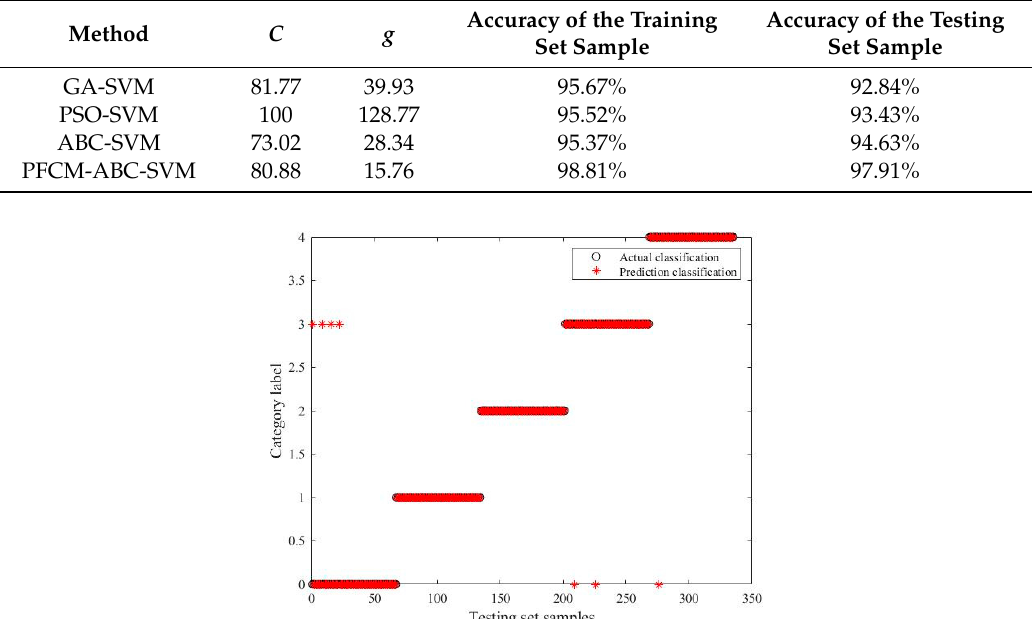
98.21% Figure 14. The classification results of the PFCM-ABC-SVM method when the Gaussian noise variance is 0.2. When the Gaussian noise variance is 0.1, the PFCM-ABC-SVM method is compared with the GA-SVM, PSO-SVM and ABC-SVM methods. The comparison between the PFCM-ABC-SVM method and the other methods is shown in Table 6. The classification results of the PEMFC-ABC- SVM method when the Gaussian noise variance is 0.1 are shown in Figure 15. The accuracy of the training set sample is 98.66%, and the accuracy of the testing set sample is 98.51% using the PFCM- ABC-SVM method.